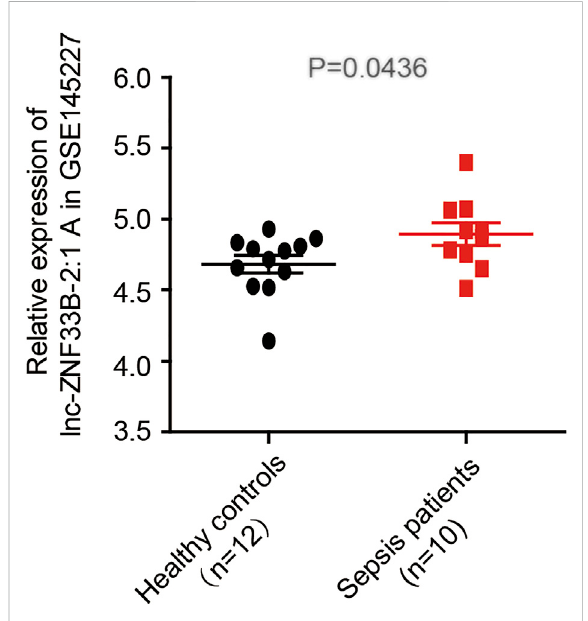
FIGURE 3 lnc-ZNF33B-2:1expressionlevelinsepsisandhealthycontrol samples (data from GSE145227), revealing that lnc-ZNF33B-2:1 shows signi fi cantly higher expression in sepsis patients ( n = 10) than normal healthy donors ( n =